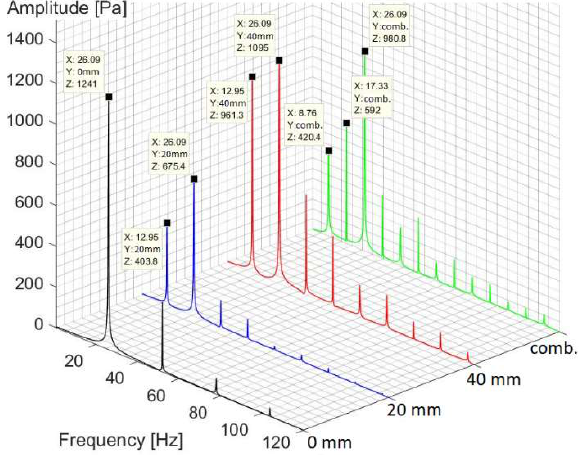
Fig. 12 Amplitude-frequency characteristics calculated from point 6 for static pressure (at 10% height of turbine chamber)